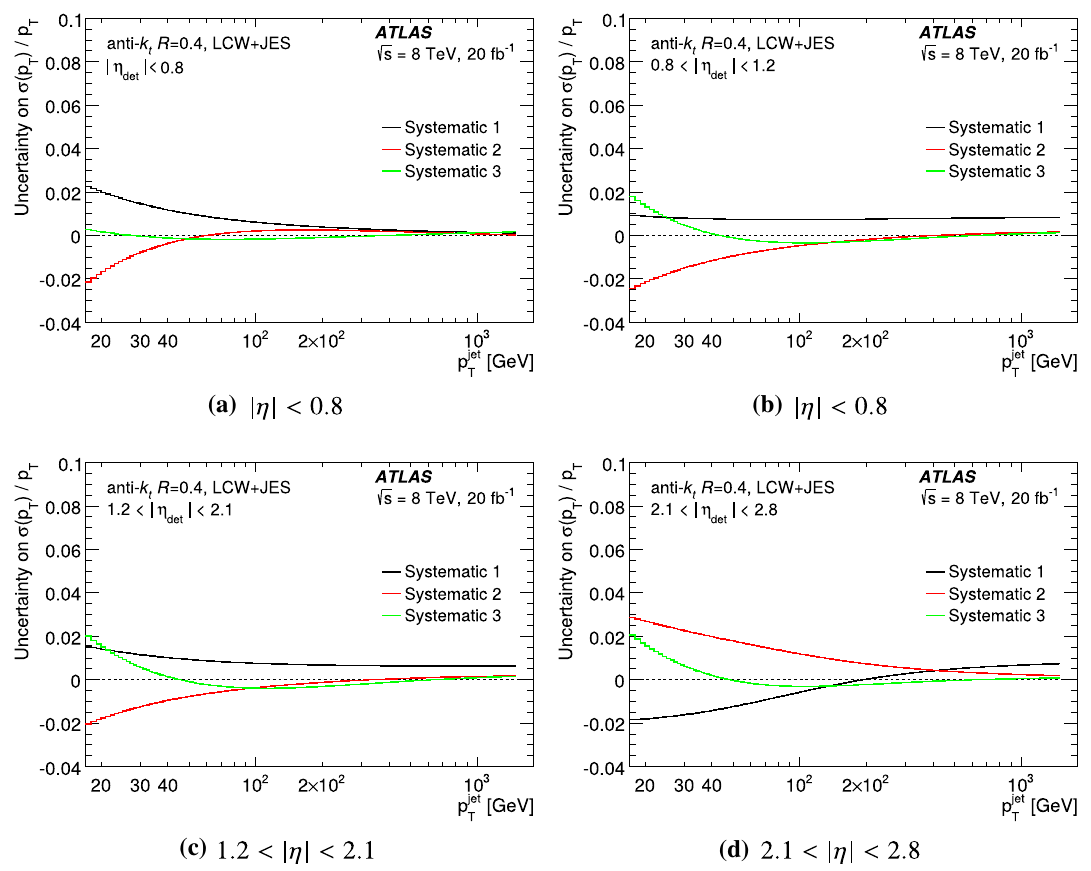
Fig. 56 The three eigenvectors after the eigenvector reduction of the nuisance parameters in the jet energy resolution measurement for LCW+JES R = 0 . 4 jets for four different | η | bins. These nuisance parameters fully describe the correlations